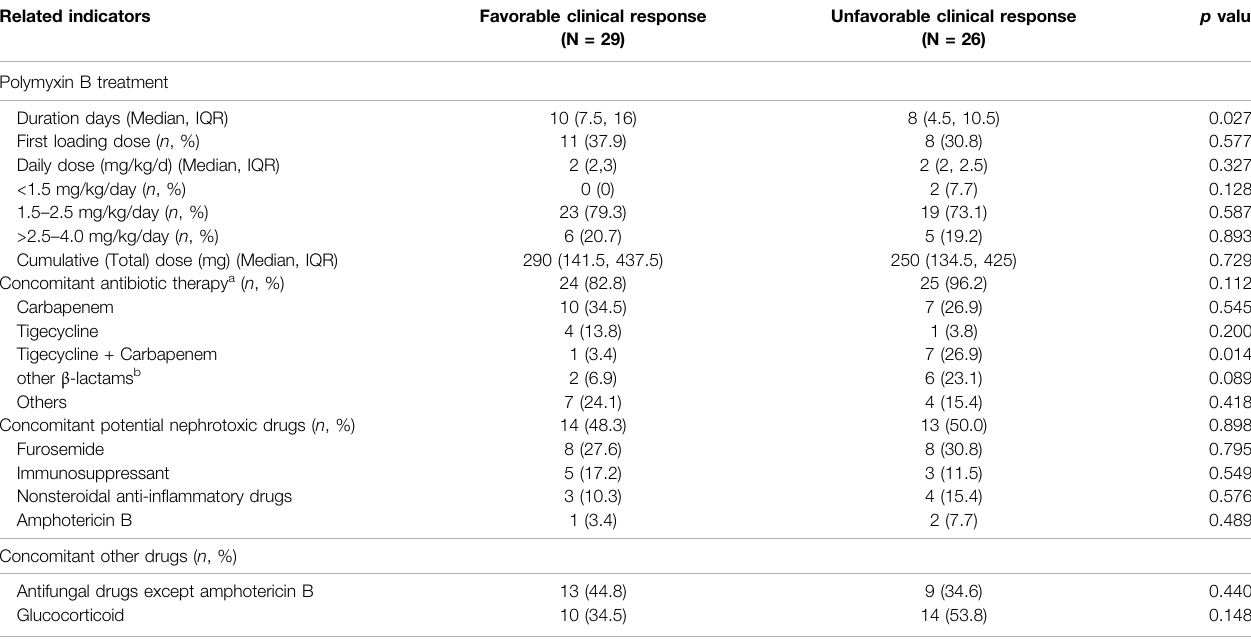
TABLE 2 | Polymyxin B dosing and concomitant drugs in patients with favorable and unfavorable clinical response. Related indicators